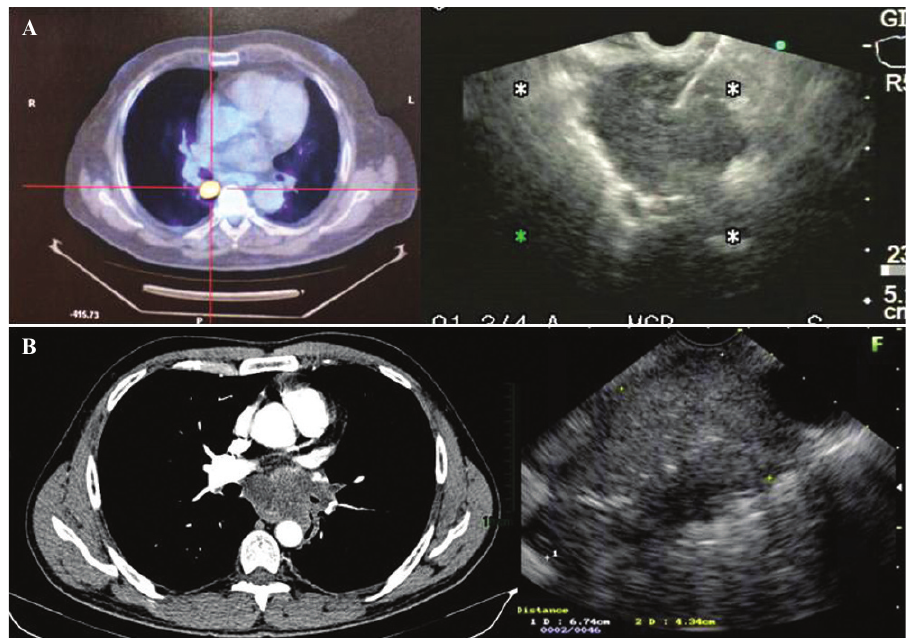
Figure 2 - A A PET scan shows a 2-cm hypermetabolic lymph node (station 10R) in an 81-year-old male patient who had already been submitted to a lower right lobe segmentectomy (adenocarcinoma) 18 months prior. EUS-FNA (notice the needle piercing the lesion) demonstrated metastatic disease. B A 46-year-old male presented chronic cough attributed to gastroesophageal reflux. Subsequent hoarseness led to a CT scan that showed a large mediastinal mass in the subcarinal and paraesophageal stations. EUS-FNA was effectively used to diagnose